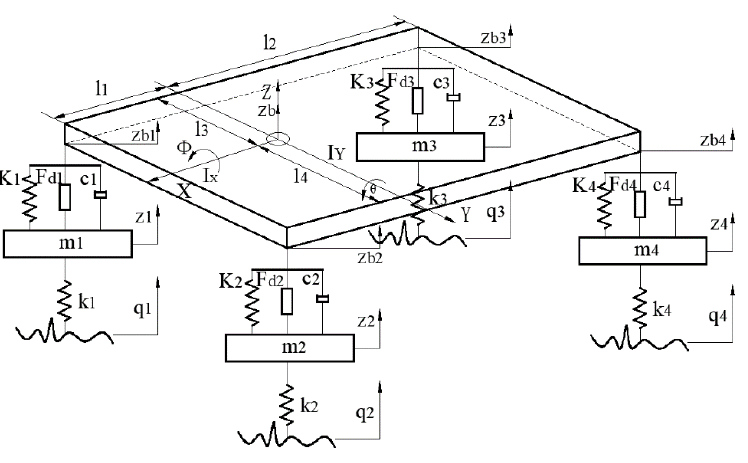
Figure 3. Model of the complete vehicle suspension system.